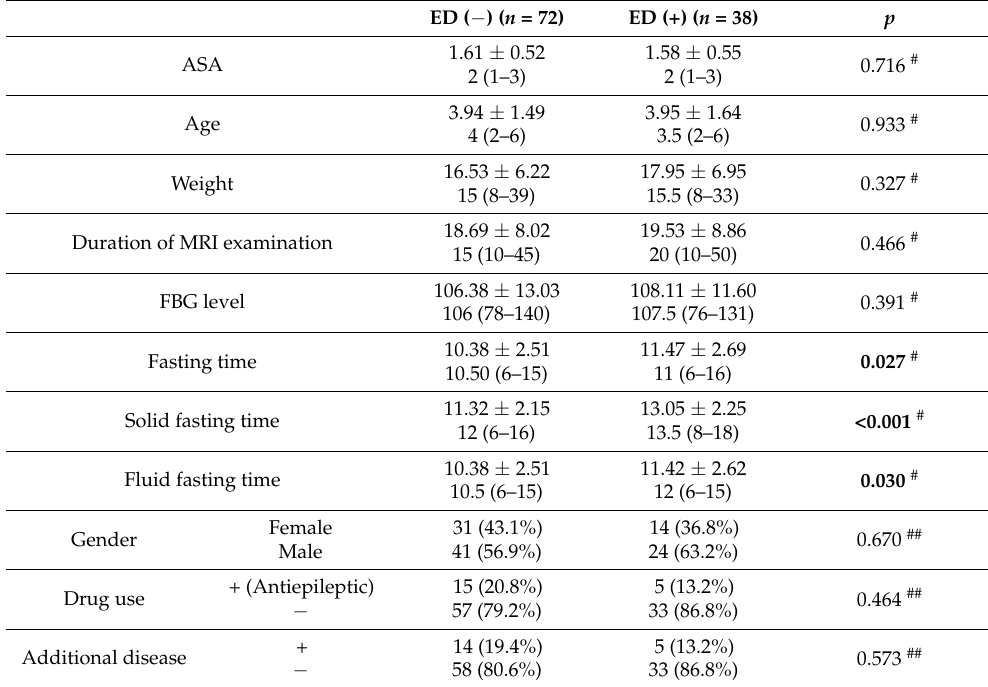
Table 3. Presence of emergence delirium according to the patient’s